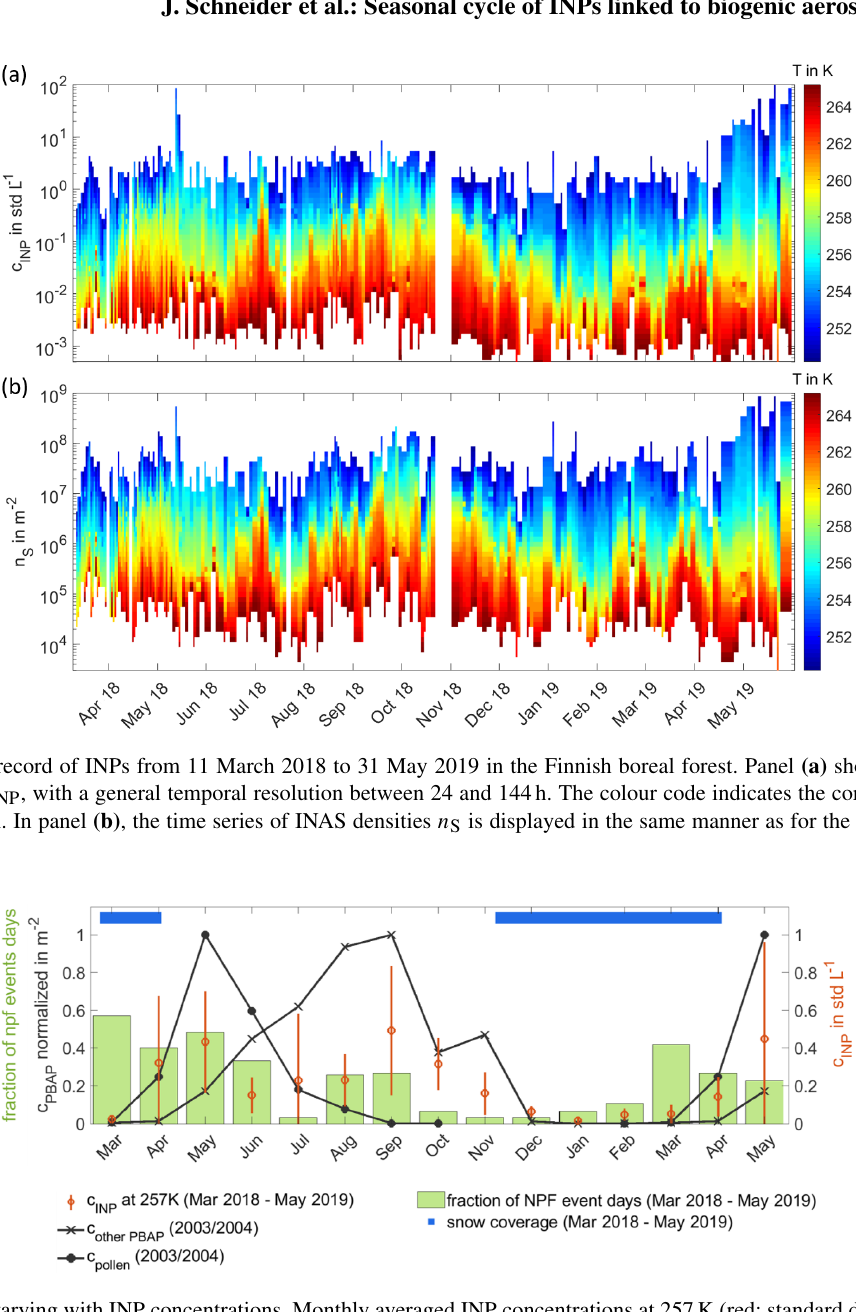
Figure 3. Factors co-varying with INP concentrations. Monthly averaged INP concentrations at 257K (red; standard deviation in error bars) are compared to the monthly fraction of NPF event days (green bars) from March 2018 to May 2019. Monthly averaged concentrations of PBAP and pollen (black dots and crosses) measured in 2003 and 2004 by Manninen et al. (2014) are additionally displayed. The blue bar is indicative of snow